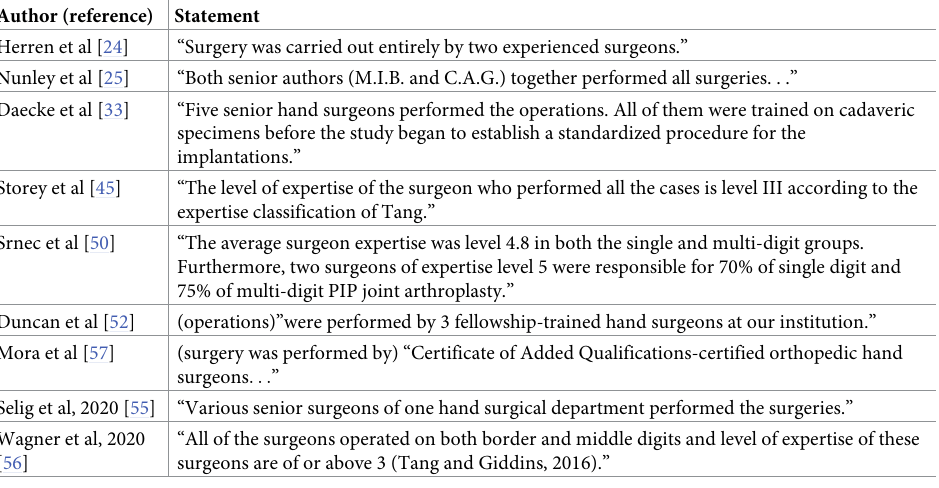
Table 3. Statements of expertise and training of participating surgeons.